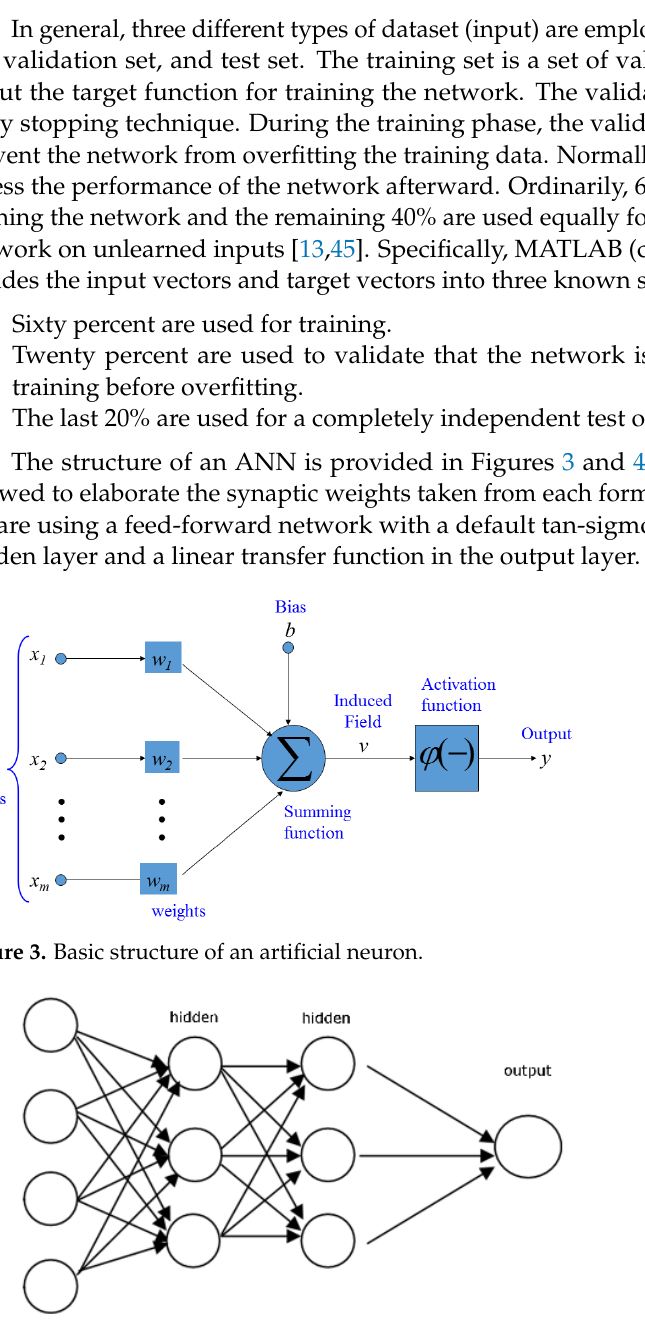
Figure 4. An illustration of a typical feedforward